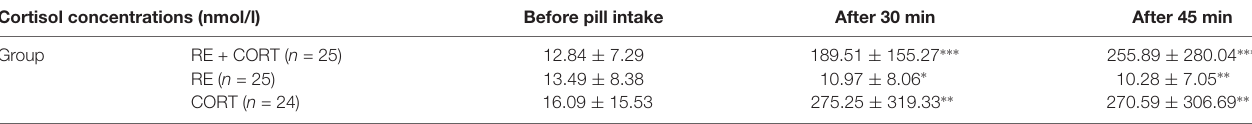
TABLE 1 | Mean (SEM) cortisol concentrations (in nmol/l) on day 2 in the three groups (RE+CORT, RE, CORT) before pill intake, 30 and 45 min after pill intake. Cortisol concentrations (nmol/l) Before pill intake